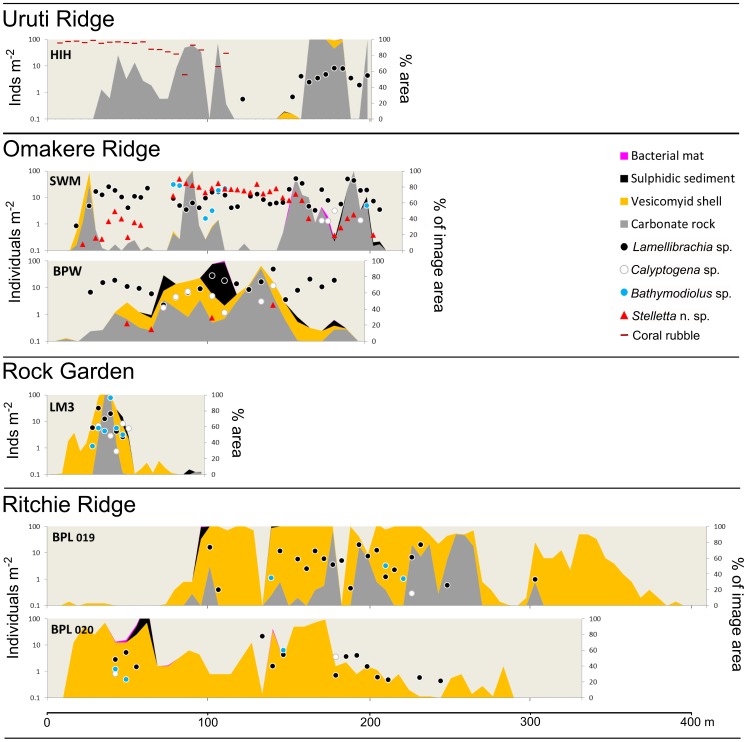
Representative profiles across selected seep sites at Uruti Ridge, Omakere Ridge, Rock Garden, and Ritchie Ridge.Site name abbreviations: HIH, Hihi; SWM, Southwest Moa; BPW, Bear's Paw; LM3, LM-3; BPL, Builder's Pencil (figures on Builder's Pencil profiles show station numbers. Station numbers for other sites: HIH, TAN0616-066; SO214-094; BPW, SO191-52-3; LM3, SO191-042). Data, symbols, and scale as for Figure 5.